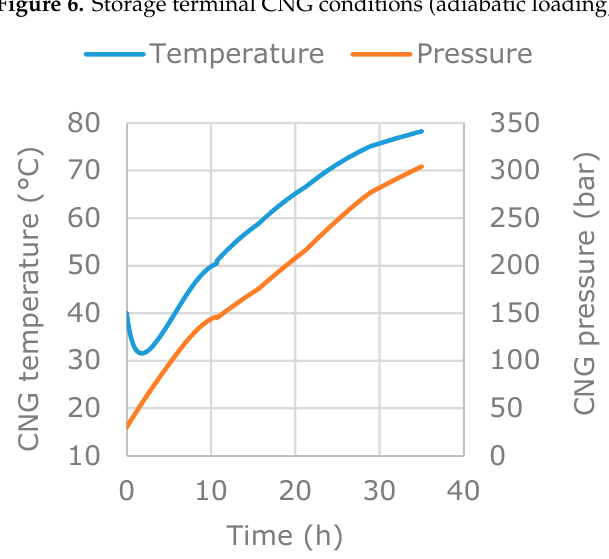
Figure 7. Pressure vessels CNG conditions (adiabatic loading).